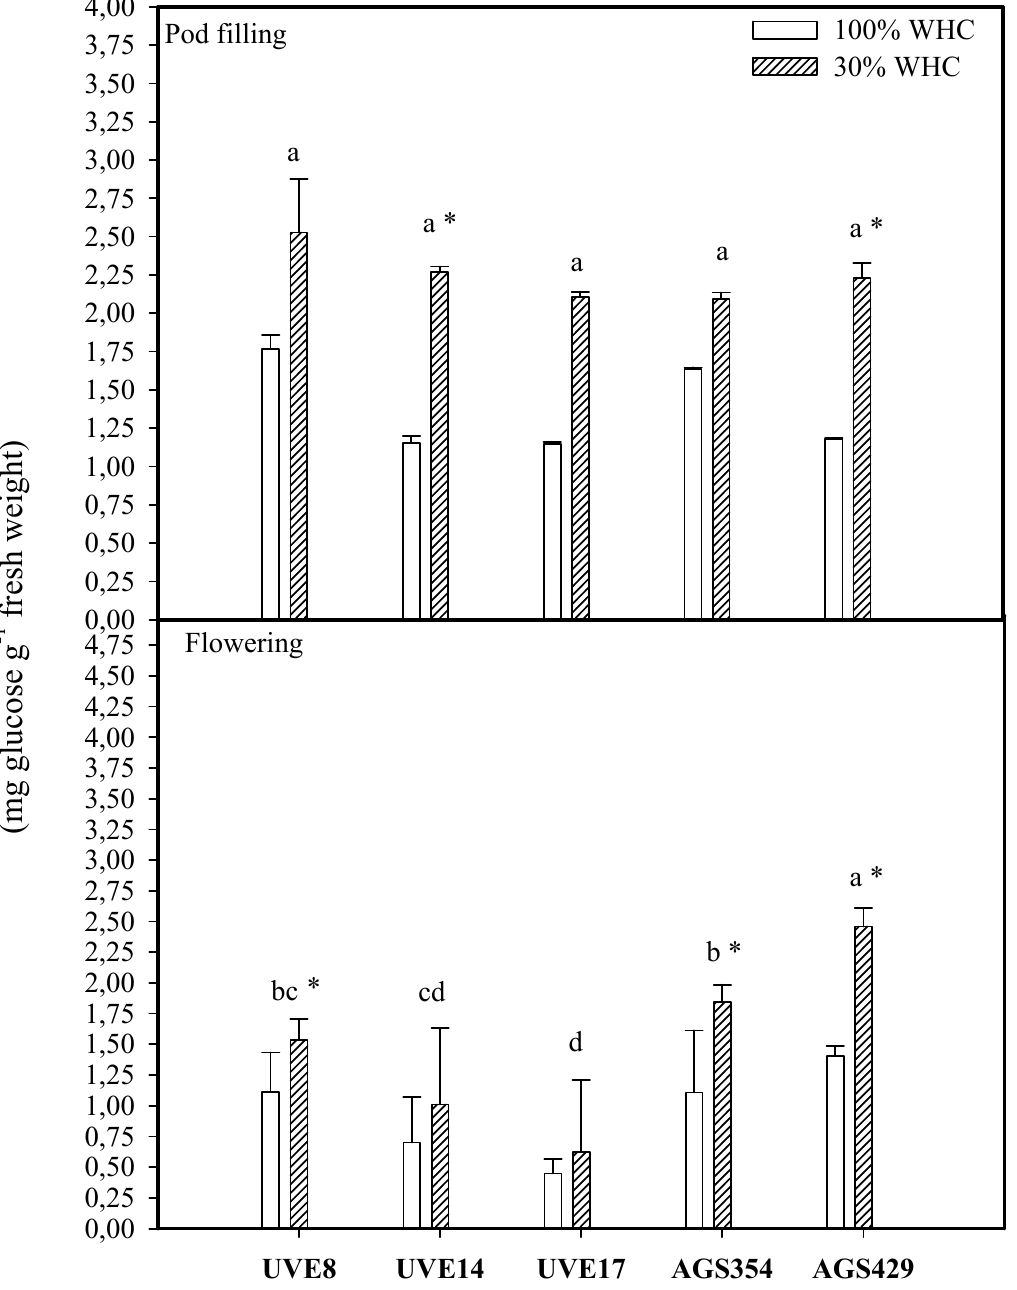
Figure 2. Total soluble sugar (TSS) content for five vegetable-type soybean cultivars subjected to two water treatments at flowering and pod-filling stages. Values represent means ± SD ( n = 3). Letters represent significant differences/similarities in TSS content for various cultivars under severe water stress at 30% water holding capacity (WHC), * represents significance at p ≤ 0.05.